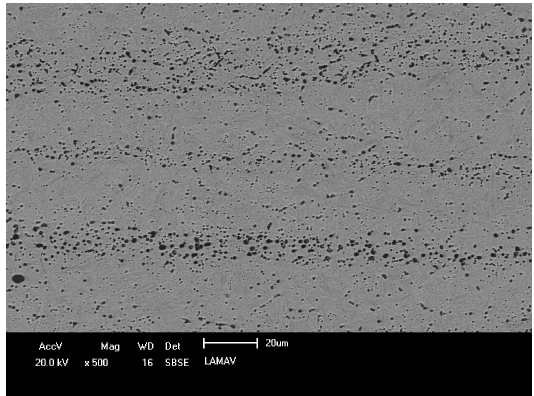
Figure 5. Microstructure of AISI 420 etched with 10wt% oxalic acid.